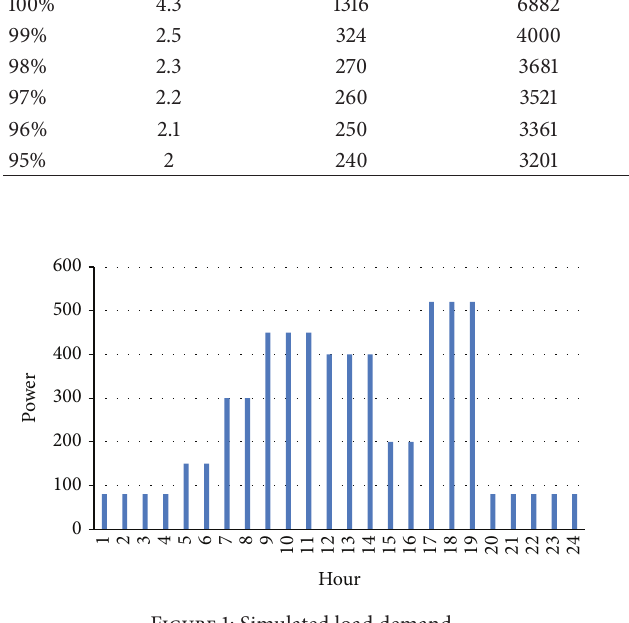
Figure 1: Simulated load